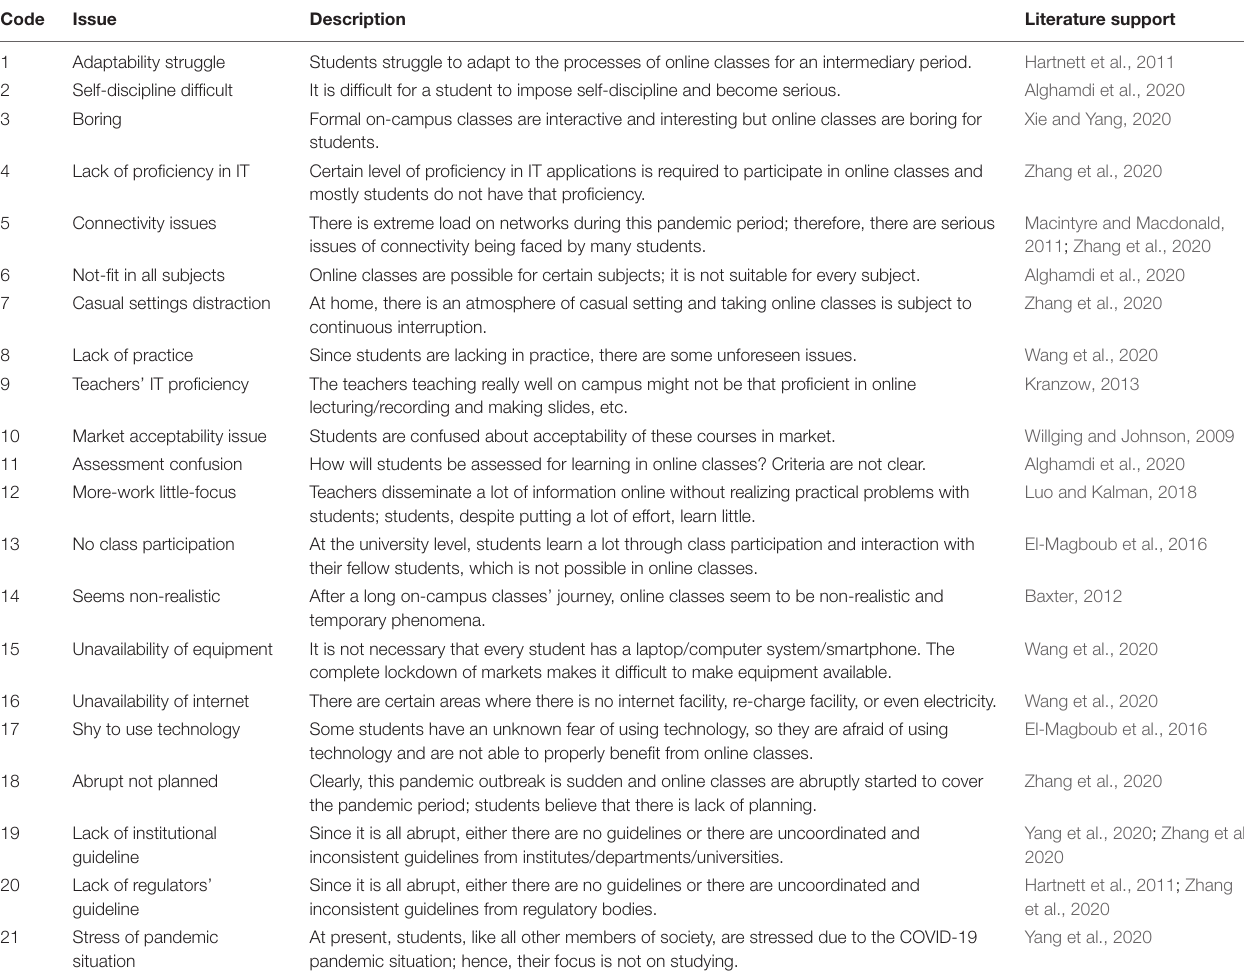
TABLE 1 | Issues faced by university students taking online classes during the COVID-19 pandemic